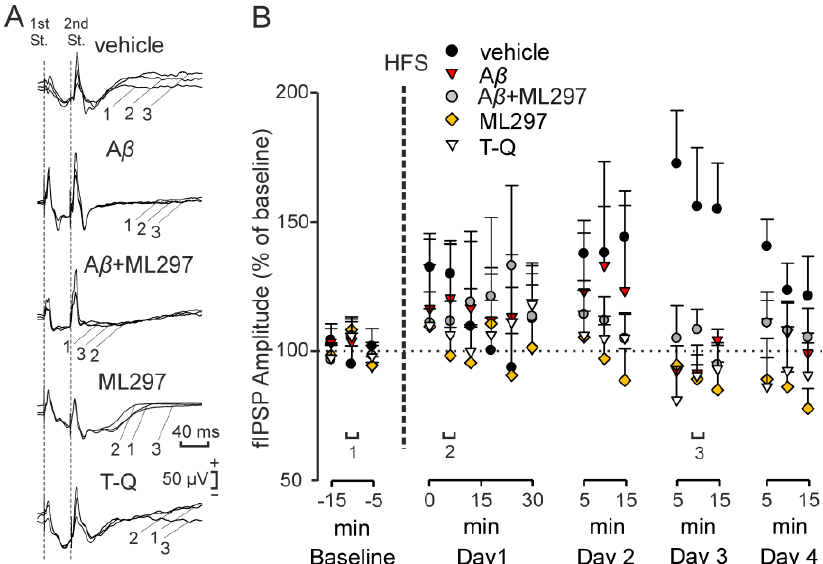
Figure 5. LTP of the GirK-channels-dependent fIPSP evoked by the second stimulus. Paired, squared, and biphasic pulses of 100 µ s were used for the establishment of the baseline in freely moving mice, after which they were subjected to an HFS protocol. Next, the same stimulation used during baseline acquisition was applied to explore the evolution of the fIPSPs mediated by GirK channels and evoked in CA1 by the second stimulus applied to the Schaffer collaterals. ( A ) Representative examples (averaged, n = 15) of the metabotropic fIPSPs evoked in the CA3–CA1 synapse by 2nd pulse stimulation at different times: after injections but before HFS (1, baseline), 10 minutes after HFS (2) and 48 hours after HFS (3). ( B ) Illustration of the data (mean ± SEM) corresponding to LTP in control animals, and mice injected with A β , A β + ML297, ML297, and T-Q. HFS, high-frequency stimulation; St.